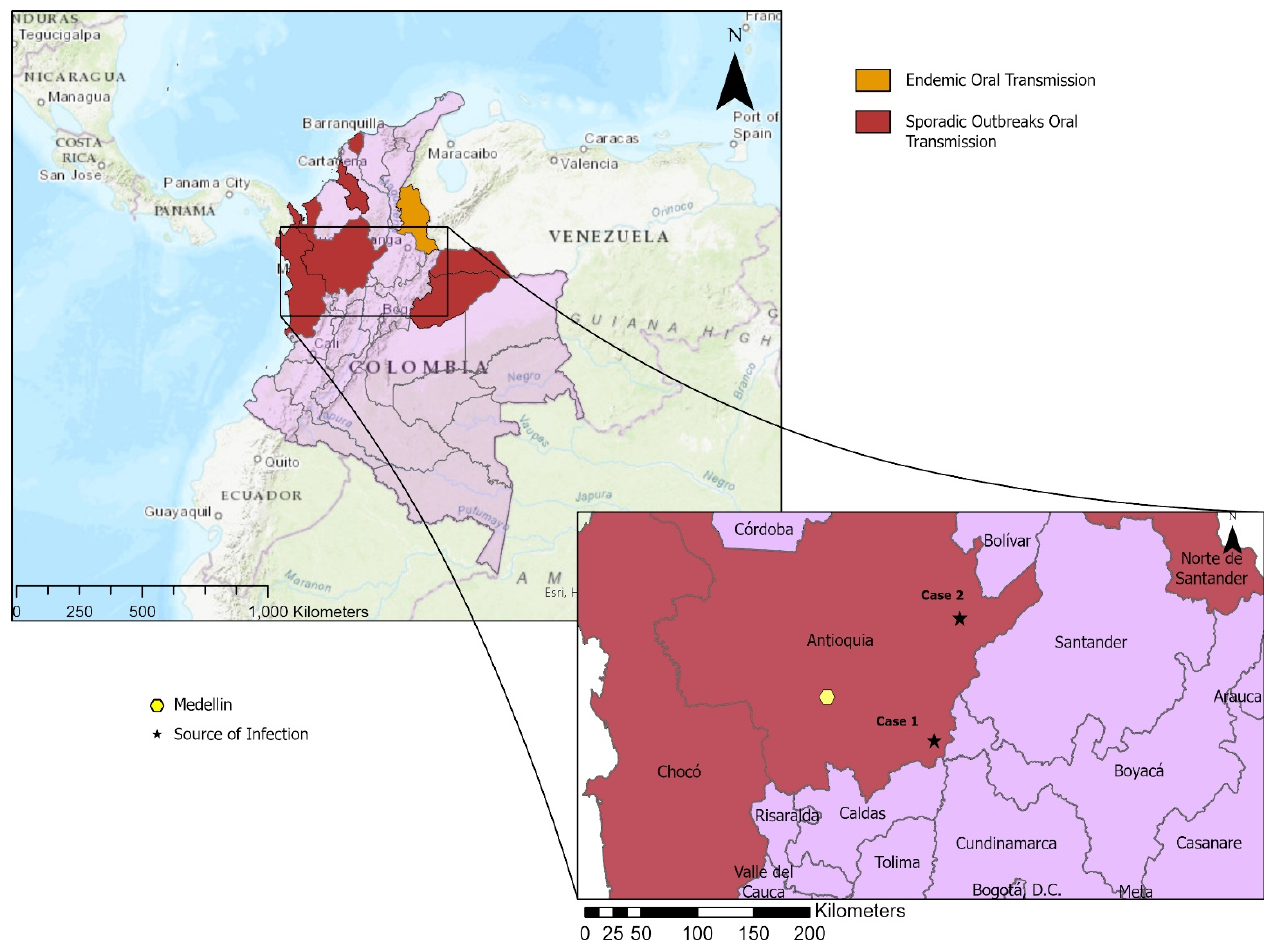
Figure 1. Map depicting the geographic location of cases and areas of historically endemic and sporadic outbreaks of oral transmission [10]. Map showing the locations of the possible transmission sites (stars) of the two cases: Case 1 in Alto del Pollo, Doradal, and Case 2 in Vereda Pueblo Nuevo, Remedios, both in the Department of Antioquia (Andean Region) and showing the biggest city nearby, Medellín (yellow hexagon).